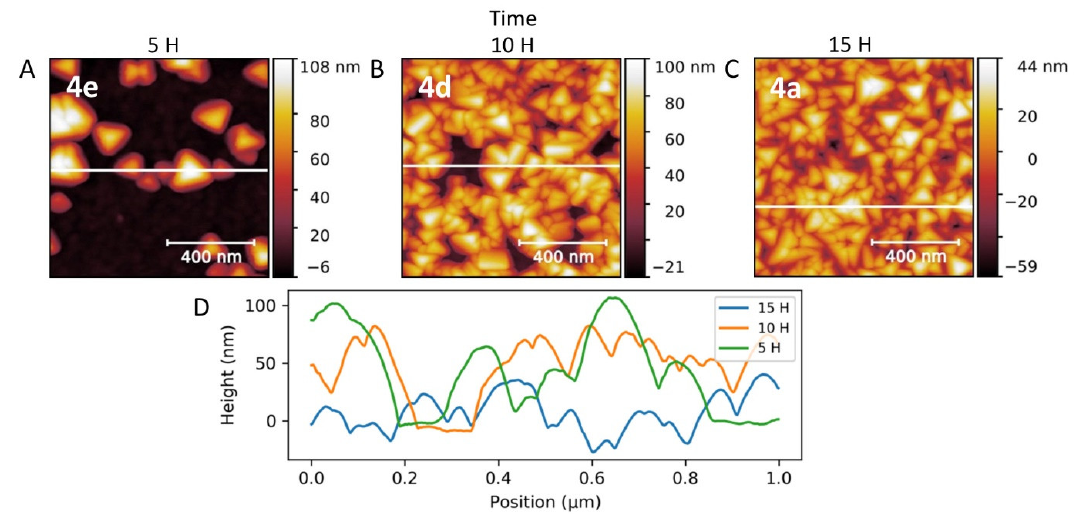
Figure 9. AFM images of samples 4a ( C ), 4d ( B ), and 4e ( A ) obtained by modulation of the reaction time for 15 h, 10 h, and 5 h, respectively; ( D ) Height profiles for the three samples.